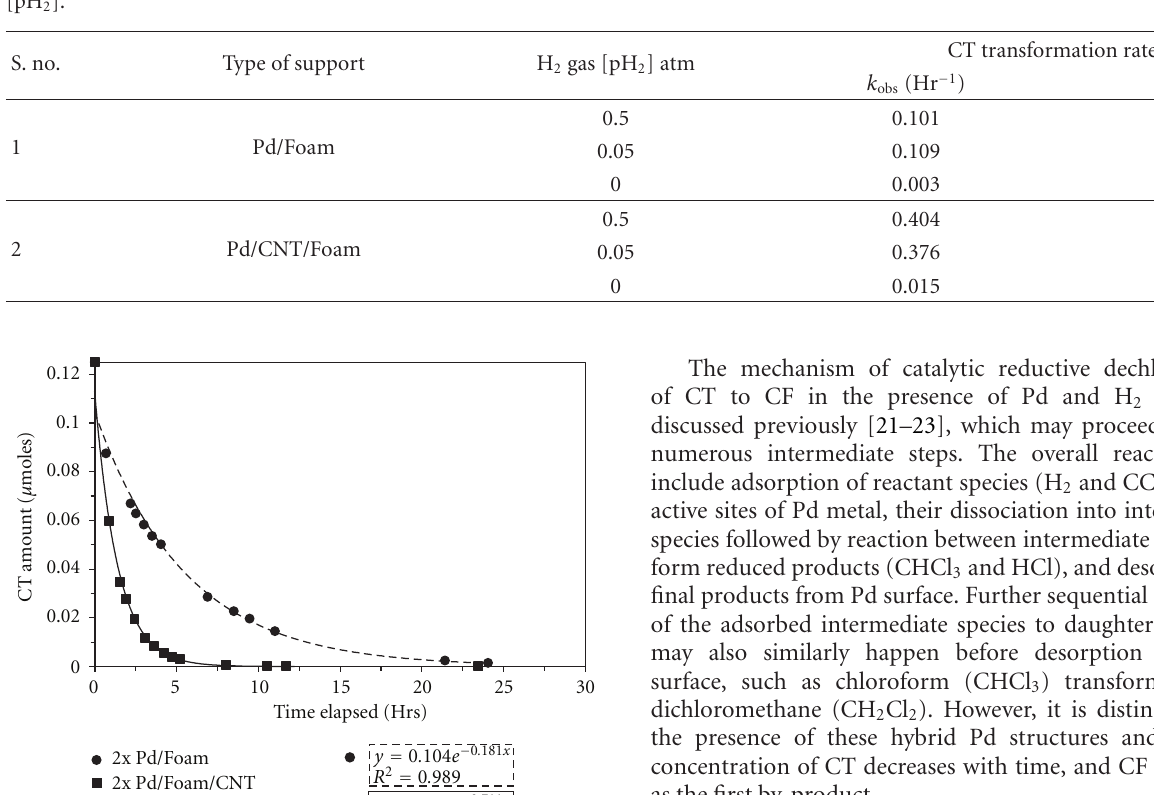
Table 2: Values of rate constants for reduction and half-life of CT ( k obs , t 0 . 5 ) with Pd hybrid catalyst and varying hydrogen gas concentrations, [pH 2 ].